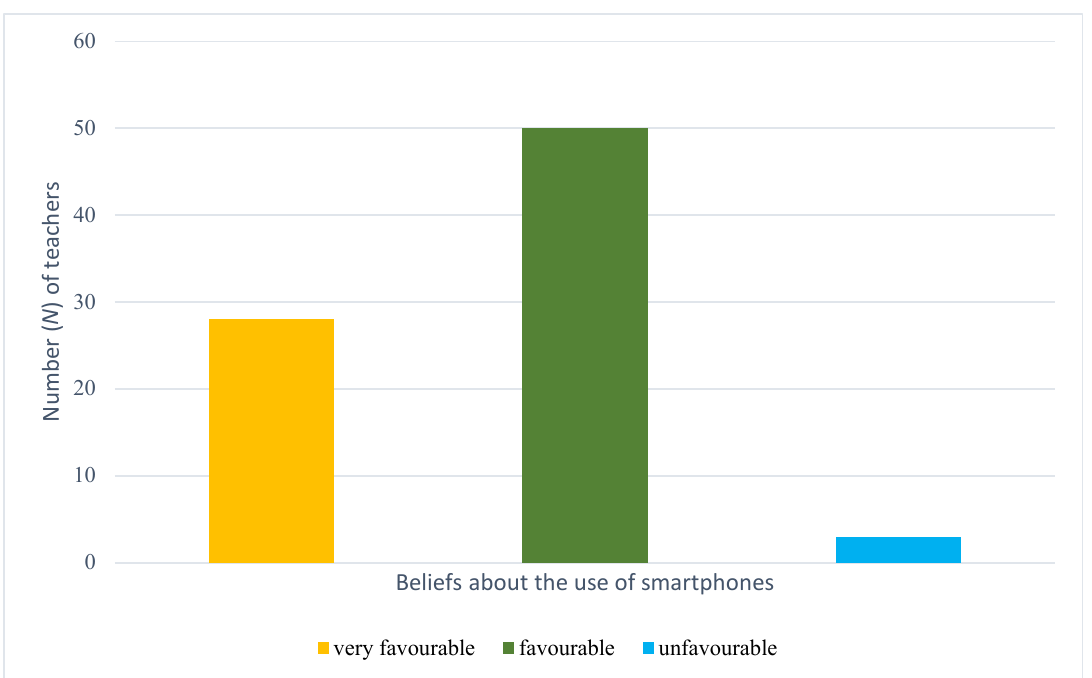
Figure 2 . Distribution of beliefs of English teachers in the potential use of smartphones for TPD. No teachers reported very unfavourable beliefs for any item.